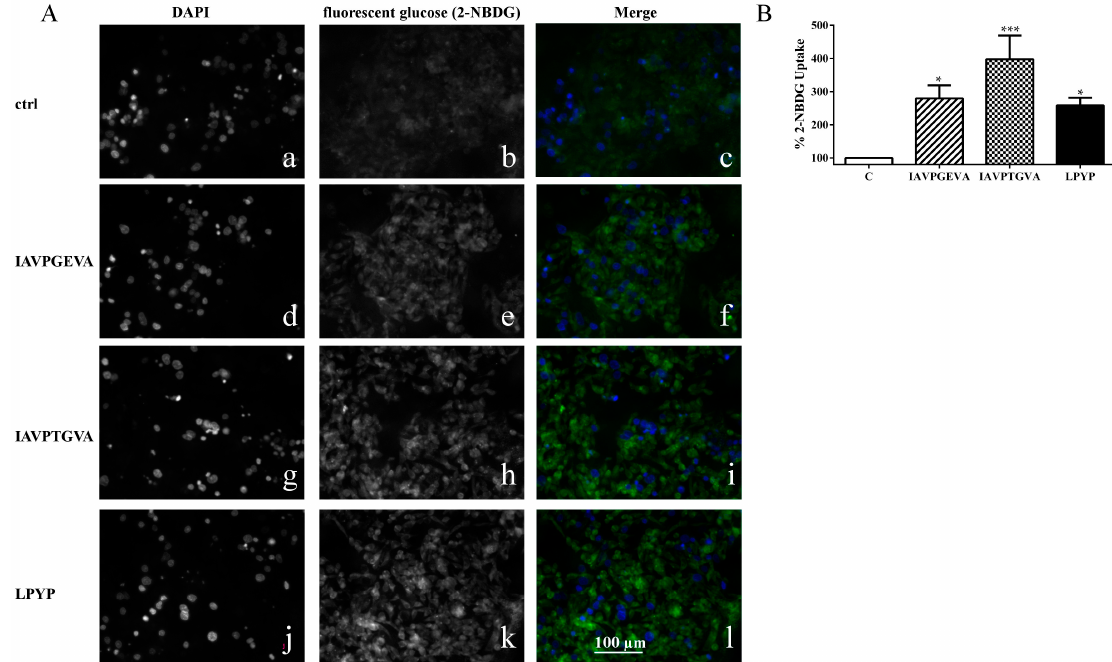
Figure 3. Qualitative and quantitative fluorescent glucose uptake analysis. ( A ) Qualitative